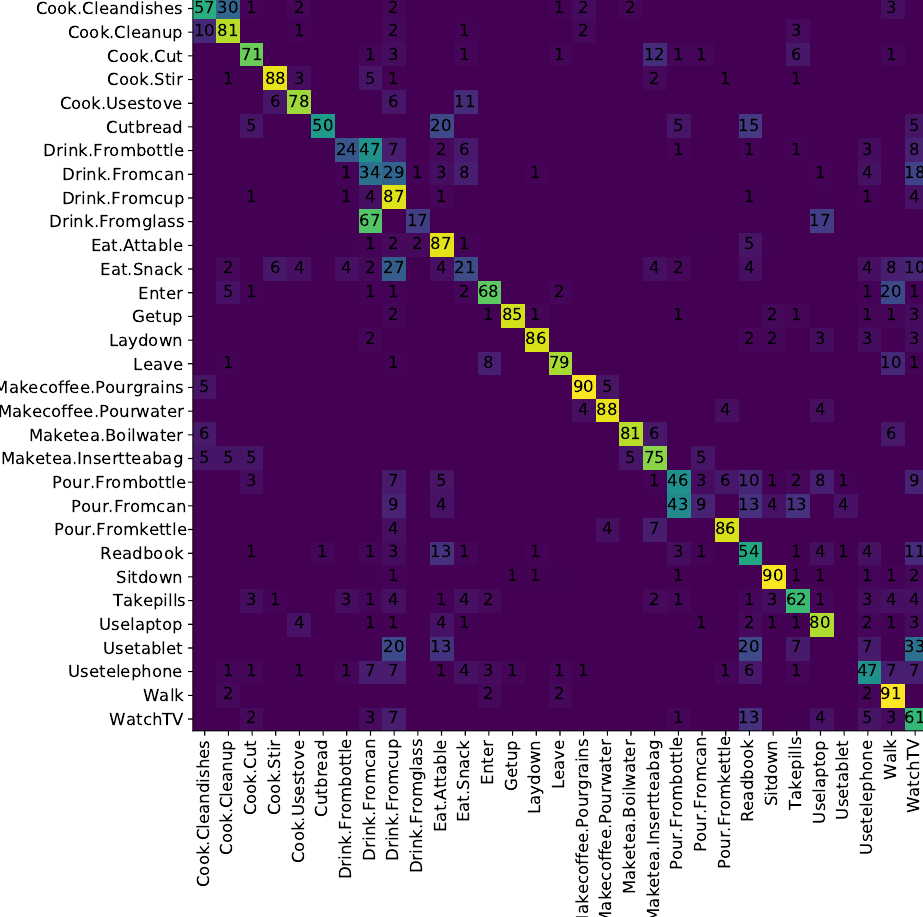
Figure 4. Confusion matrix (in %) for the best cross-subject separable STA result (‘Rotation’).